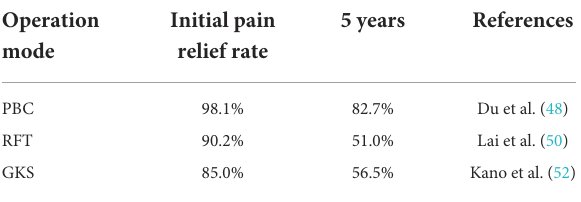
TABLE 2 Treatment of recurrent TN and pain control